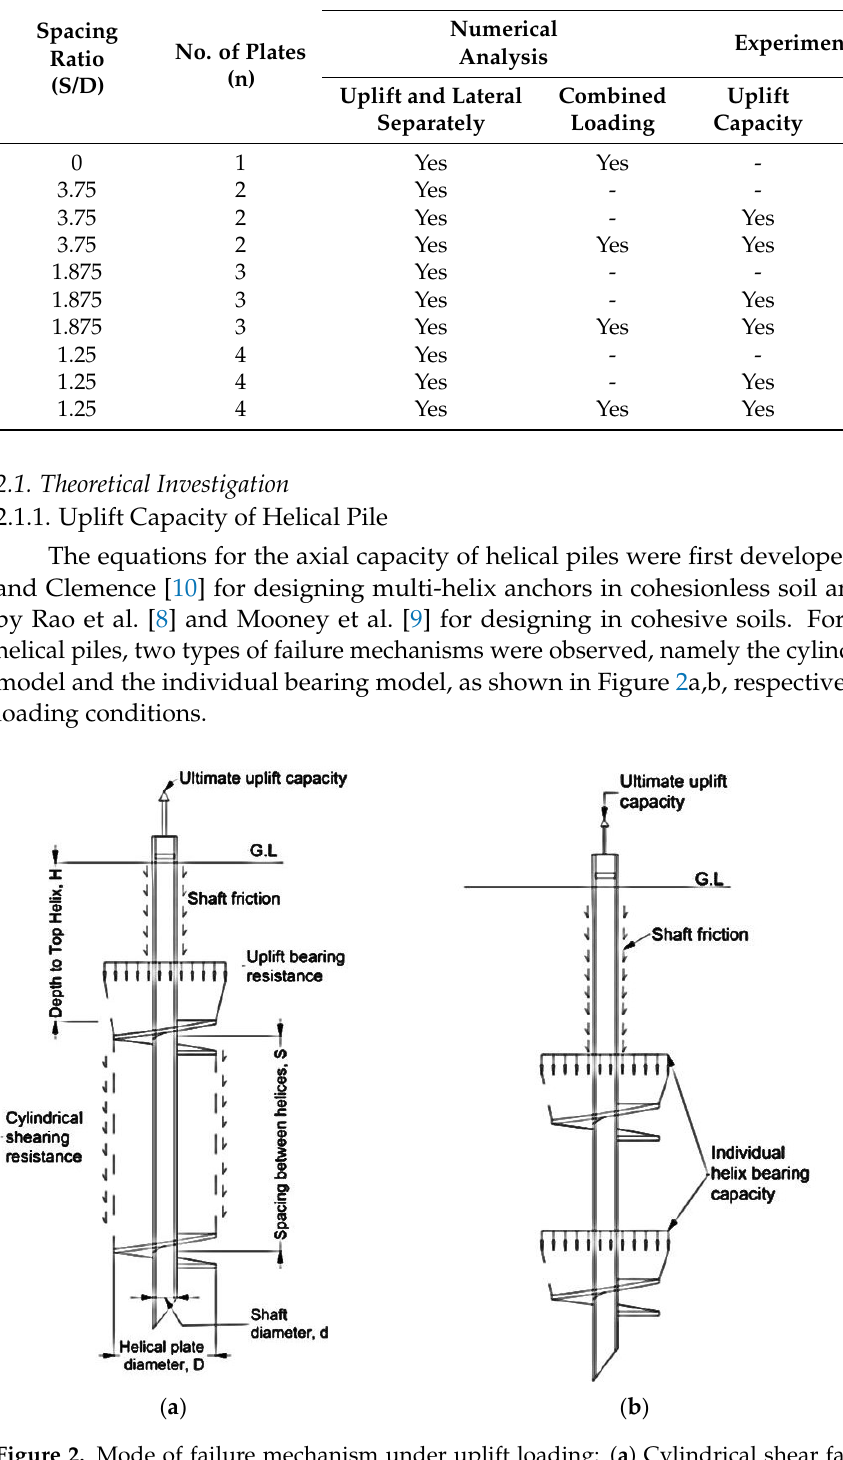
Table 1. Overview of testing program.